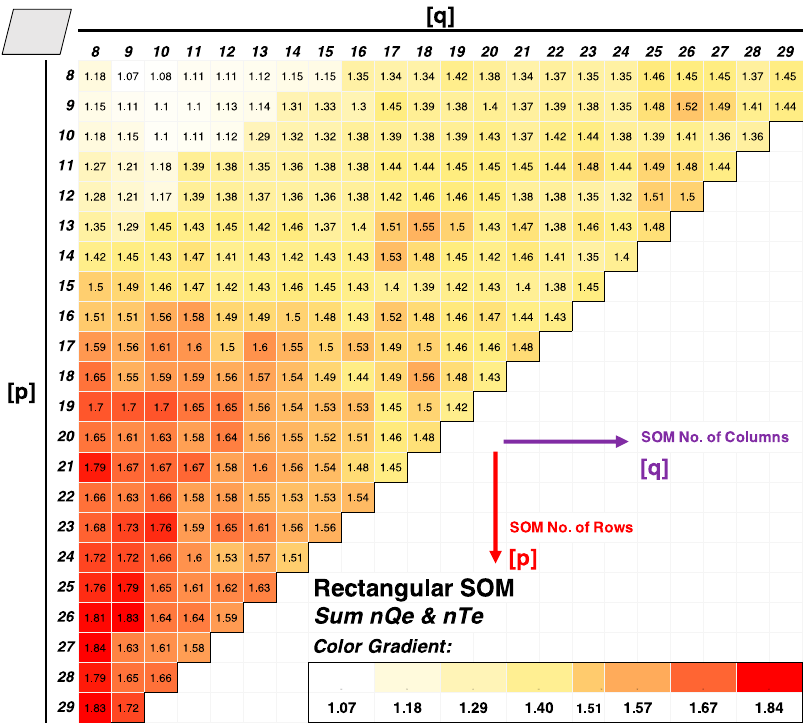
Figure 4. Sum of normalized topographic error (Te) and normalized quantization error (Qe) for rectangular SOM in hexagonal lattice at number of rows and number of columns of the SOM lattice.